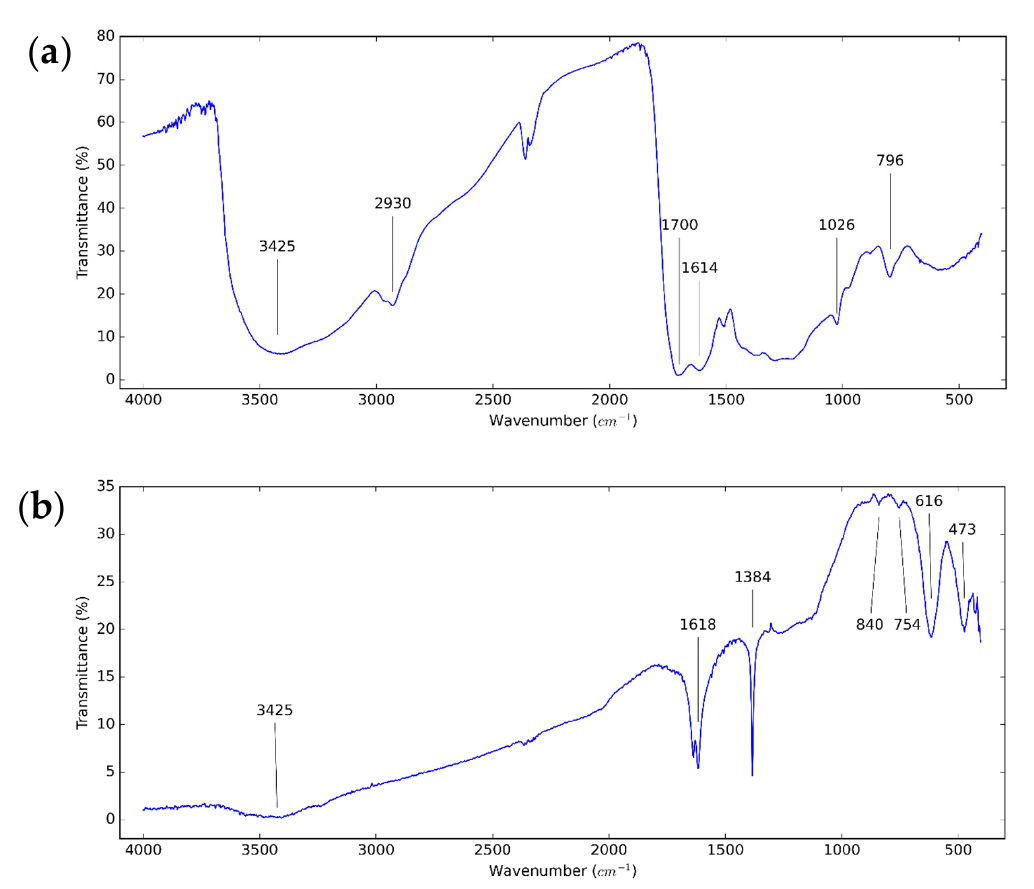
Figure 3. FT-IR spectrum of ( a ) CNS and ( b ) CNP dry particles.